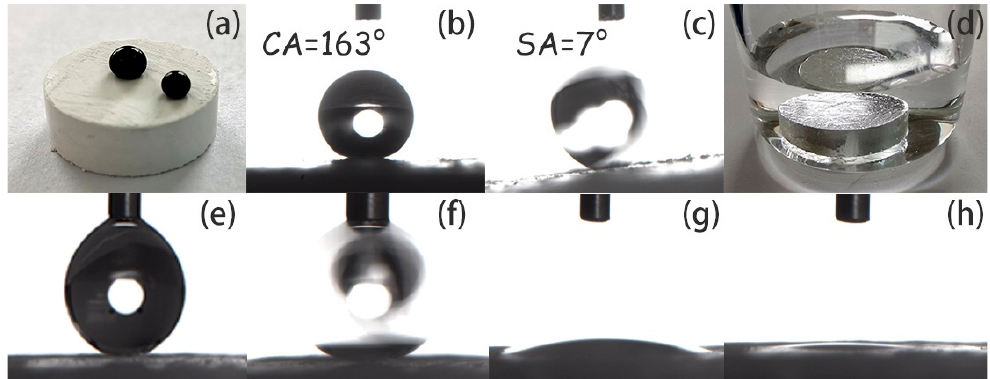
Figure 1. ( a ) Digital image of a water droplet containing ink on the sample surface. ( b ) Contact angle (CA) of the sample surface. ( c ) Sliding angle (SA) of the sample surface. ( d ) Digital photo of the sample in water. ( e – h ) Digital image of a water droplet touching a block made of untreated ZnO powder.